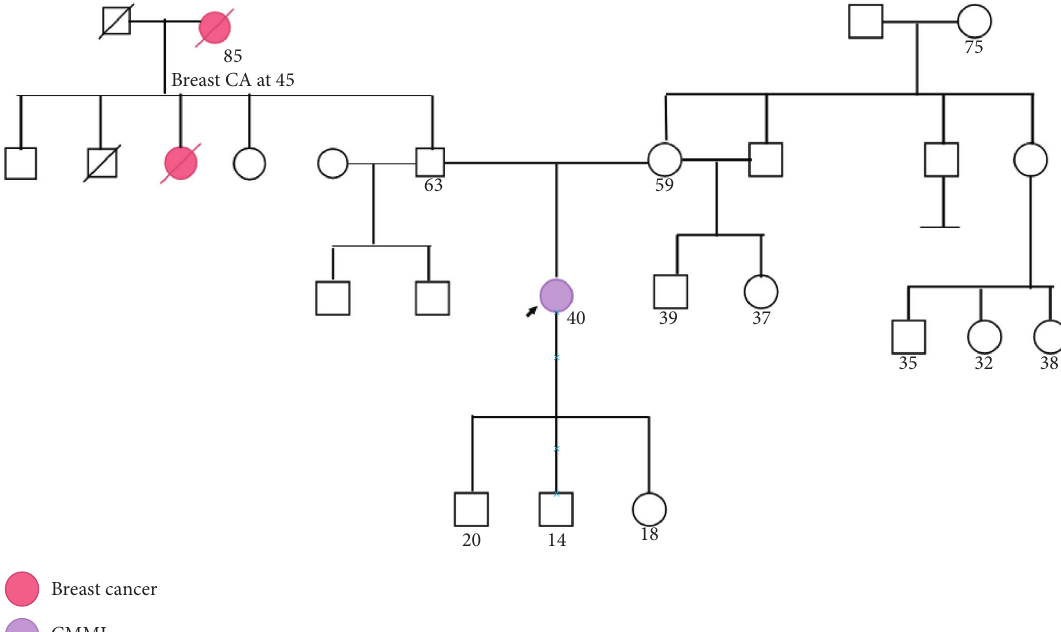
Figure 2: Pedigree chart of the